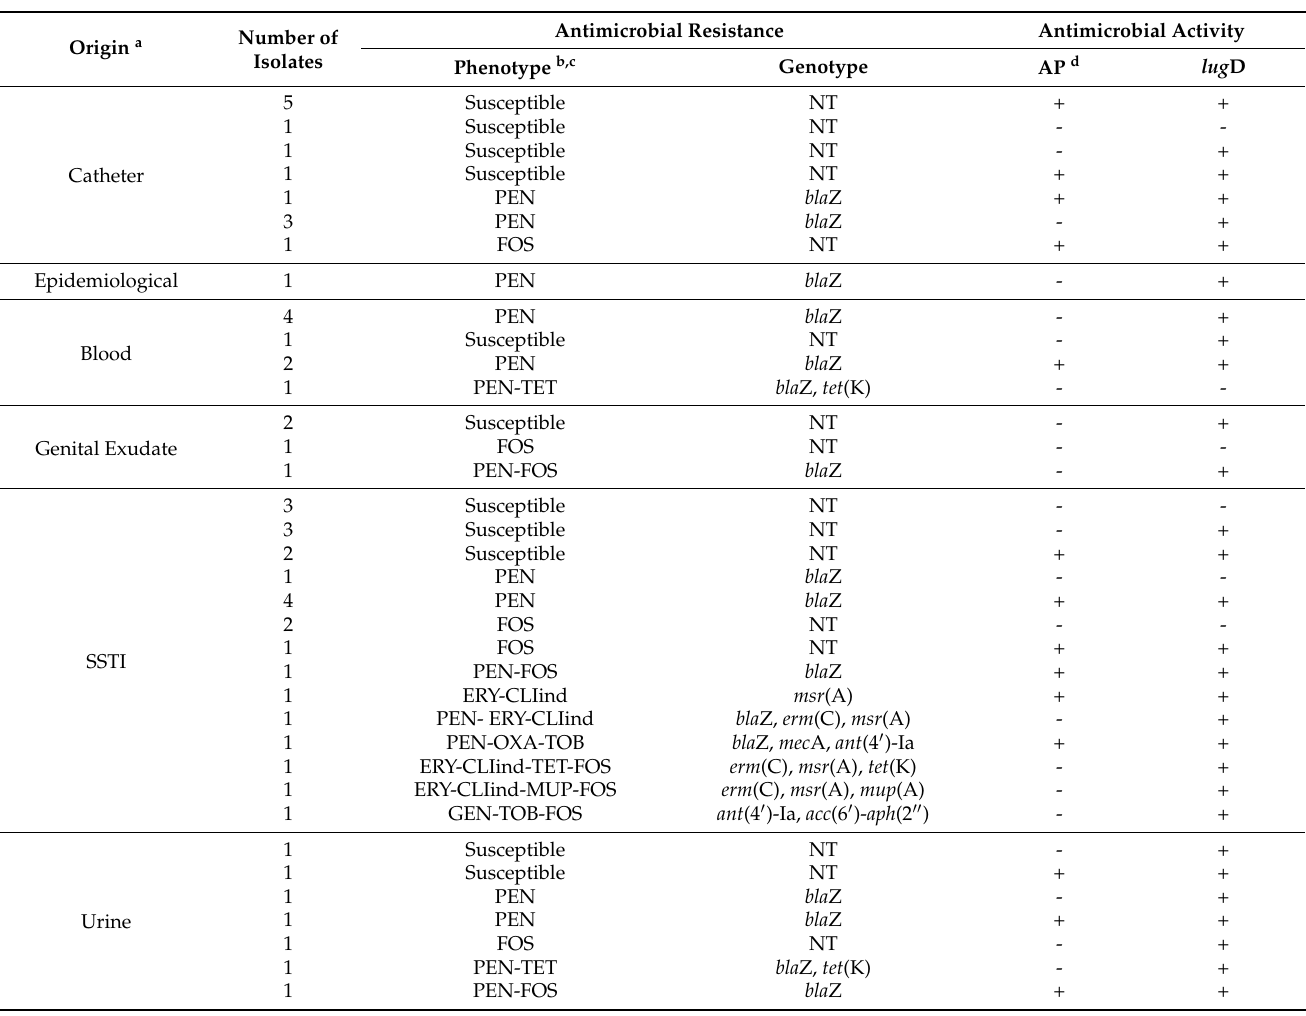
Table 1. Origin, antimicrobial resistance phenotype and genotype, antimicrobial activity production (AP) and bacteriocin genes of the 56 S. lugdunensis isolates included in this study.